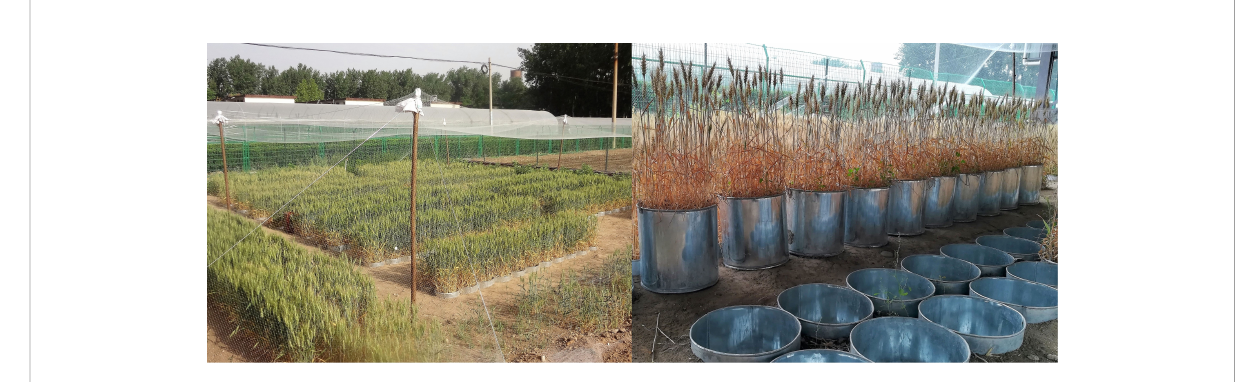
FIGURE 1 Photos of the experiment at ripening.